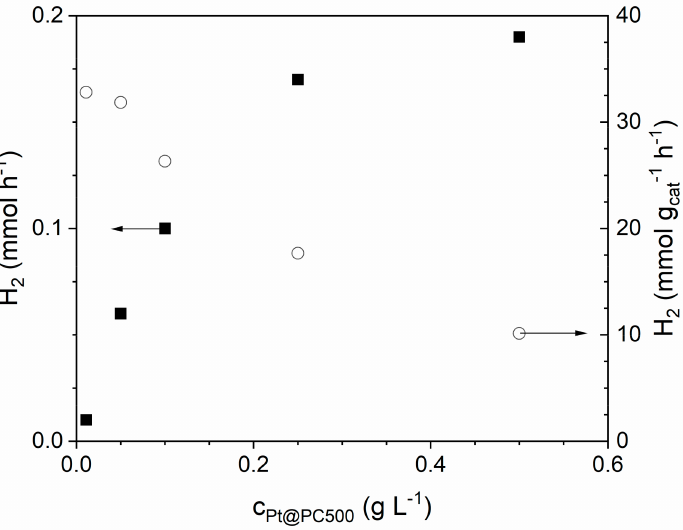
Figure 4. Hydrogen productivity with Pt MS @PC500 (0.37 wt% Pt, T = 30 ◦ C, t = 2 h, 300 W Xe lamp (full spectrum), and 10 vol.%